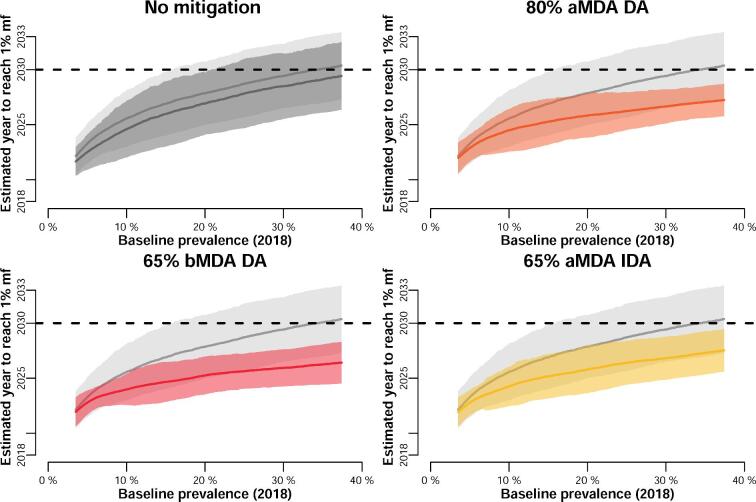
Estimated year of achieving the 1% mf threshold relative to the prevalence at baseline (assumed here in 2018) for the setting with Culex transmission treated with DA. Top-left plot compares the counterfactual to the no-mitigation scenario (after a 12-month delay). The rest of the plots show the different acceleration strategies (in colour) against the no-mitigation situation (in grey). The horizontal dashed line indicates the year 2030; areas beyond 2030 are unlikely to reach the goal. The solid line shows the moving average (window size of 4000) and the shaded area is the standard deviation (volatility).